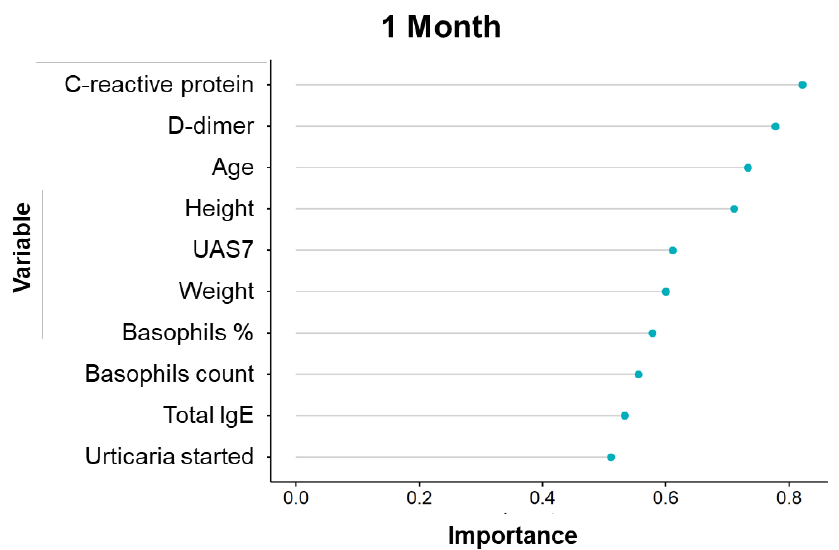
Figure 4. Variable Importance Analysis for the prediction of the response to omalizumab after 1 month treatment.